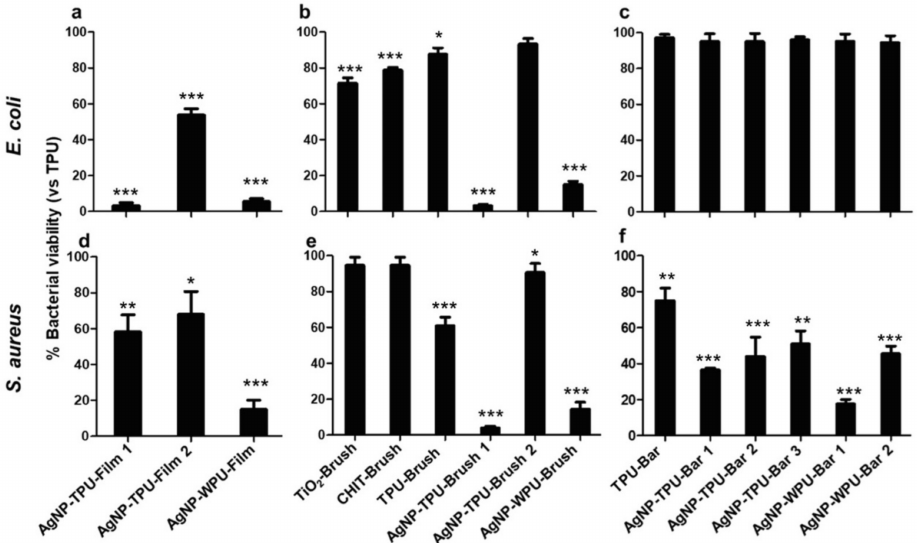
Figure 8. Adherent cell viability of E. coli ( a – c ) and S. aureus ( d – f ) cultures on polymeric films. After 24 h of incubation with TPU and WPU-deposited materials, both bacterial cultures were removed and cell viability evaluated by an MTT test. The figure shows the percentage of viability of all 15 samples related to TPU set as 100%. Bars indicate mean values ± SD of the mean of results from two experiments. *- Student’s t -test, statistical significance values were p < 0.05 (*) and p < 0.01 (**), and p < 0.001